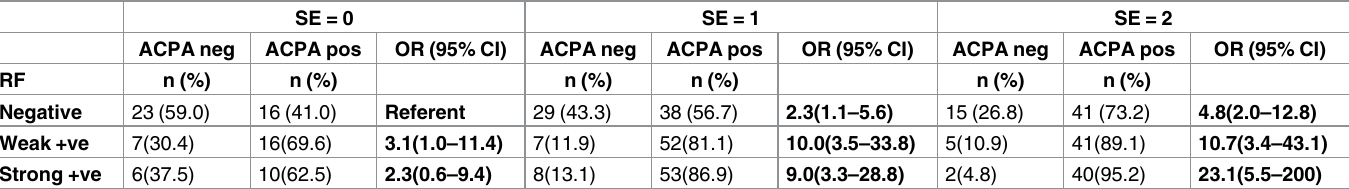
Table 4. Cohort 2 relationship between RF levels, ACPA and shared epitope status (n = 409).